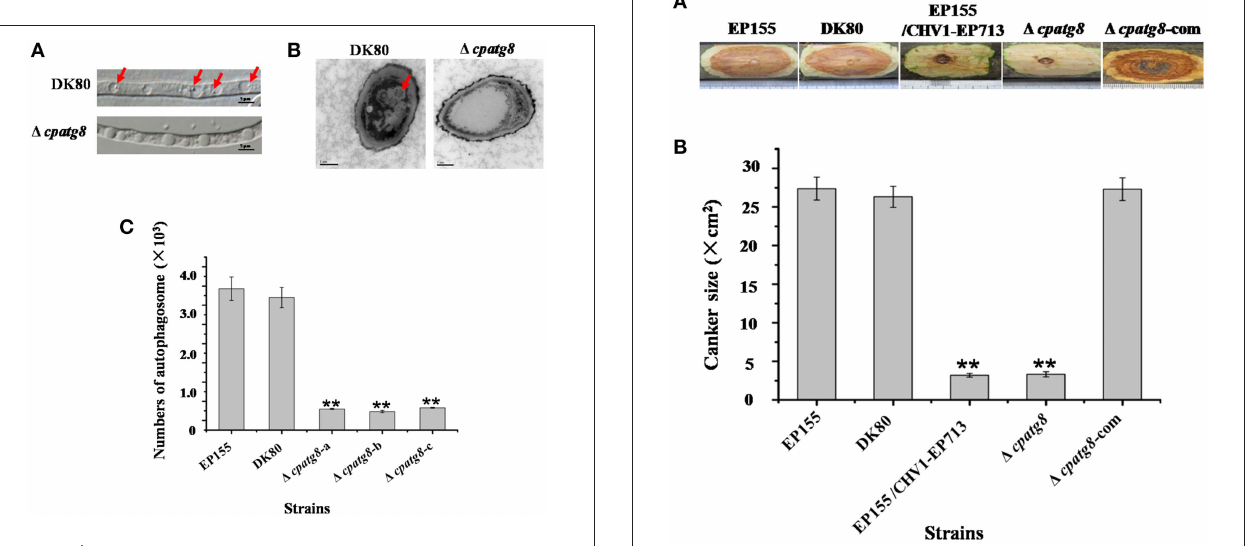
FIGURE 6 | Virulence assay on chestnut stems. (A) Cankers induced by the tested strains. The wild-type (EP155), starting (DK80), and hypovirus-infected (DK80/CHV1-EP713) strains and cpatg8 -deleted ( 1 cpatg8 ) and cpatg8 -complemented ( 1 cpatg8 -com) mutants were inoculated onto Chinese chestnut ( C. mollissima Blume) stems. The inoculated stems were kept at 24 ◦ C and cankers were measured and photographed on day 28 postinoculation. (B) Canker size measurements of the tested strains. The assays were with five duplicates for each strain. Values are means ± SEM of three independent experiments. ** indicates P < 0.01, determined by Student’s t